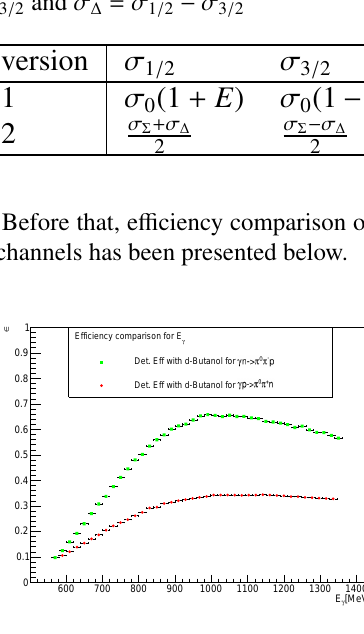
Figure 3: Detection e ffi ciency comparison for the channels γ p → π 0 π + n (red dots) and γ n → π 0 π − p (green dots) are shown above. It also indicates the higher e ffi ciency for proton detection than that for the channel with neutron in final state.